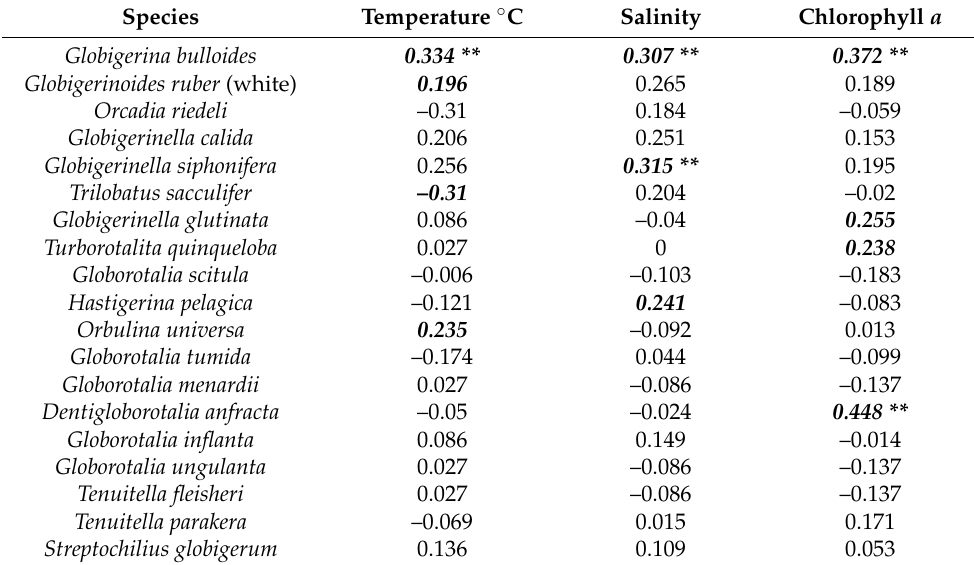
Figure in bold italics and asterisks ** used for significant at the p <